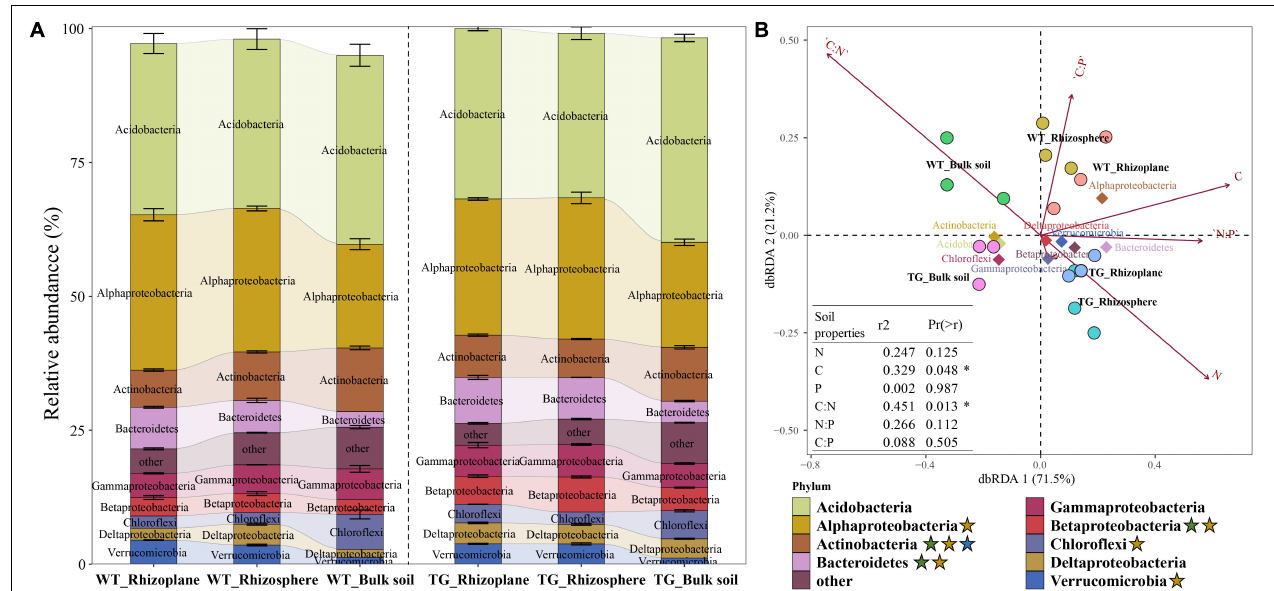
FIGURE 3 | (A) Bacterial relative abundance with Phylum of each zone in two cultivars. The green star represents that the relative abundance of the bacteria is different between breeds; the yellow star represents that the relative abundance of the bacteria is different among different soil layers; and the blue star represents that the relative abundance of the bacteria is different both between breeds and among different soil layers. (B) Distance-based Redundancy analysis of different zones, abundant classes, and 6 environmental factors (arrows) indicates the dominant communities and influential environmental